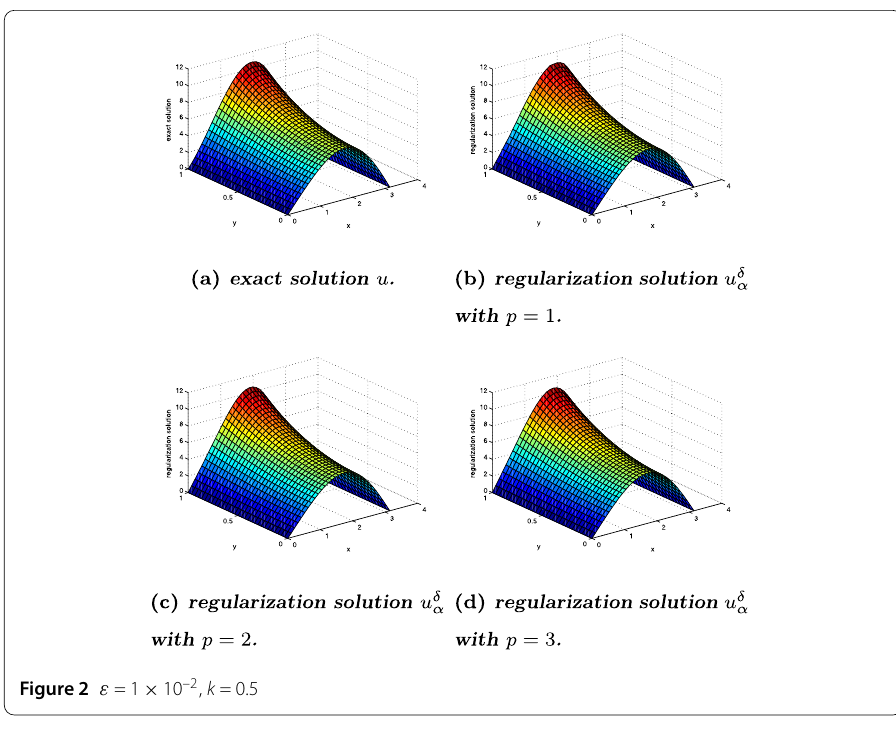
Figure 2 ε = 1 × 10 –2 , k = 0.5